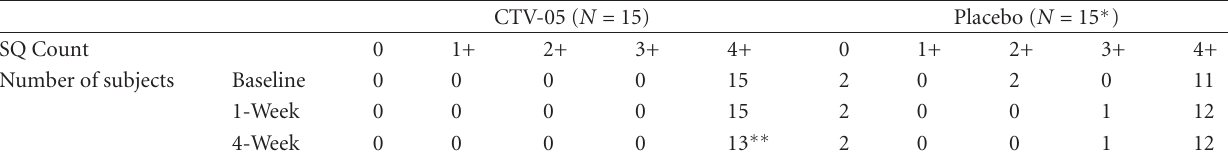
Table 4: Subjects with vaginal H 2 O 2 -producing Lactobacillus detected at follow-up clinic visits. CTV-05 ( N = 15) Placebo ( N = 15 ∗